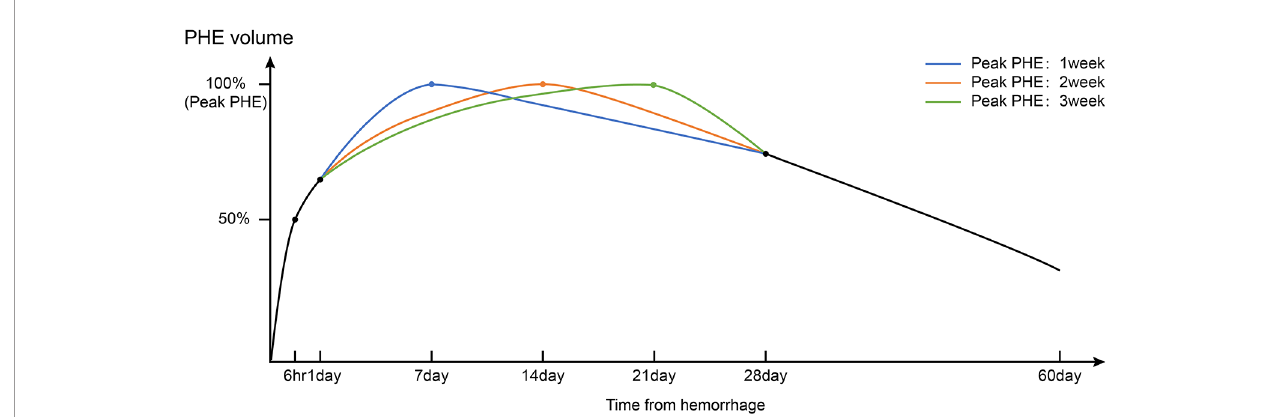
FIGURE 2 | Timeline of PHE volumes after intracerebral hemorrhage based on real-world clinical research of the natural history of PHE. Triphasic patterns of growth of PHE (fast-growing phase: 1 – 3 days; slow-growing phase and peak period: 1 – 3 weeks; resorption phase: >3 weeks)